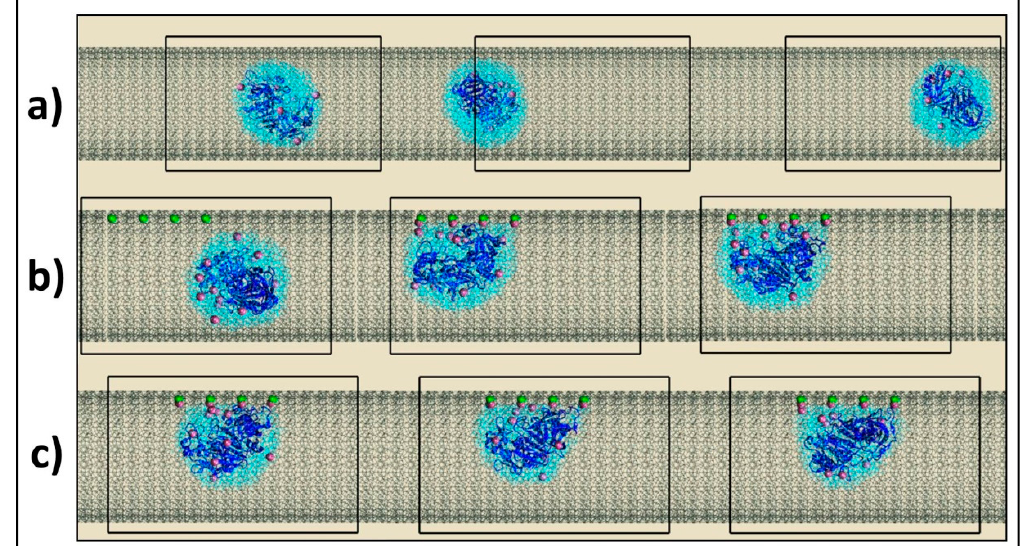
Figure 1. ( a ) Snapshots for evenly sampled configurations (time is growing left to right) from the simulation with a neutral cylindrical mesopore (Model 1). ( b ) Snapshots taken from the simulation with a charged mesopore (Model 2). ( c ) Snapshots taken from the simulation with a negatively charged silica channel and a lower number of water molecules (Model 3). The mesoporous matrix is shown as gray lines. Deprotonated silanols and potassium cations are represented as green and purple spheres respectively. Water molecules are represented as light blue lines. Pepsin is represented as a blue ribbon structure. The simulation box (in the yz plane) is shown as black